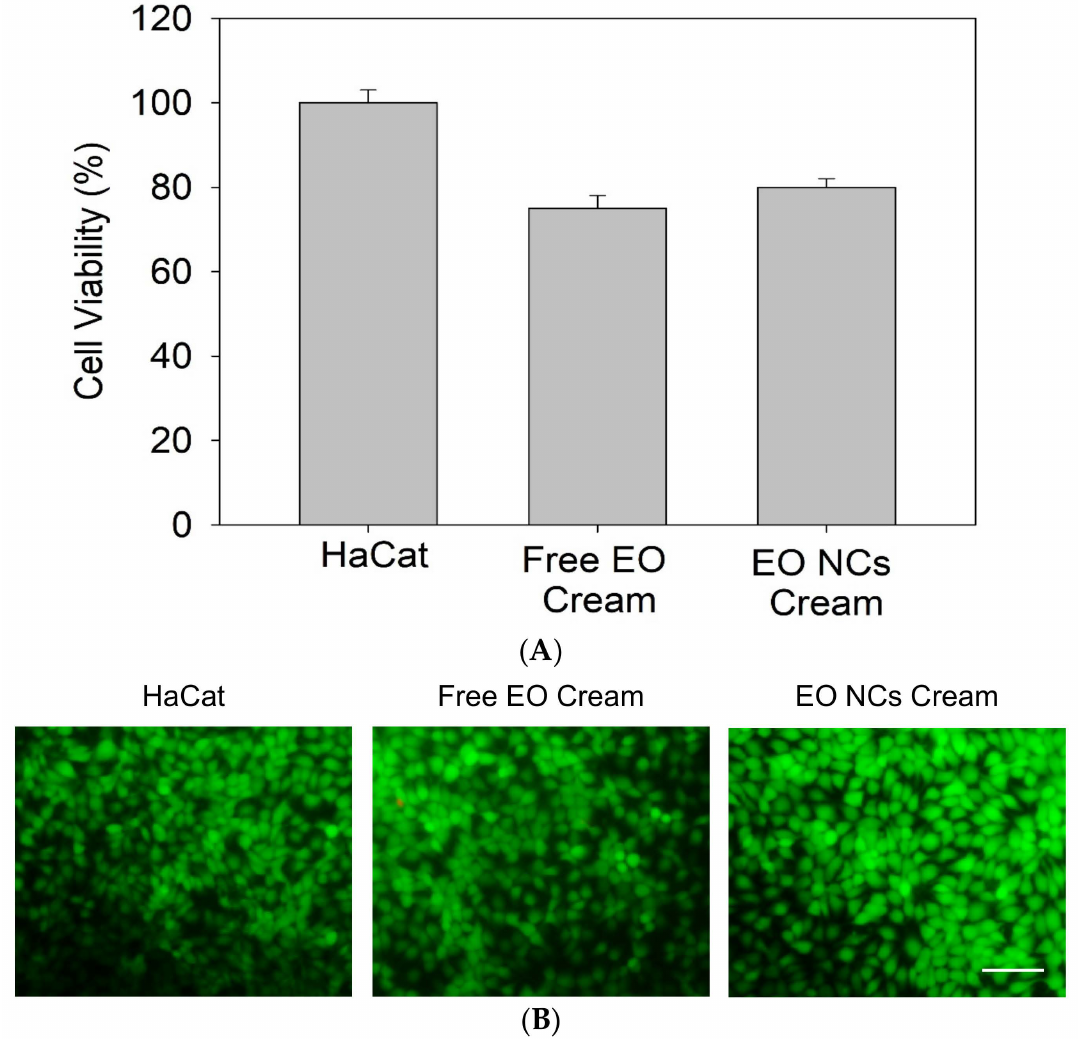
Figure 6. Biocompatibility of the free EO and EO-loaded NC anti-acne creams assessed by ( A ) Alamar Blue and ( B ) Live/Dead assay in HaCaT cells. All experiments were performed in triplicate, and the data are expressed as the mean ± standard